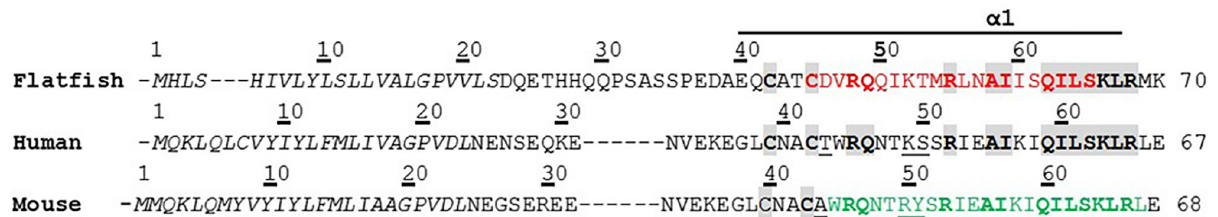
Fig 8. Amino acid sequences from 1 to 70 of flatfish myostatin propeptide aligned with those of mouse and human. The italic characters indicate signal sequence. The bold shaded amino acid residues indicate the same sequence identity within the α 1 helix region among the three species. The underlined amino acid sequences indicate different sequences within the α 1 helix region between mouse and human. The α 1 helix domain is based on Shi et al. [46].